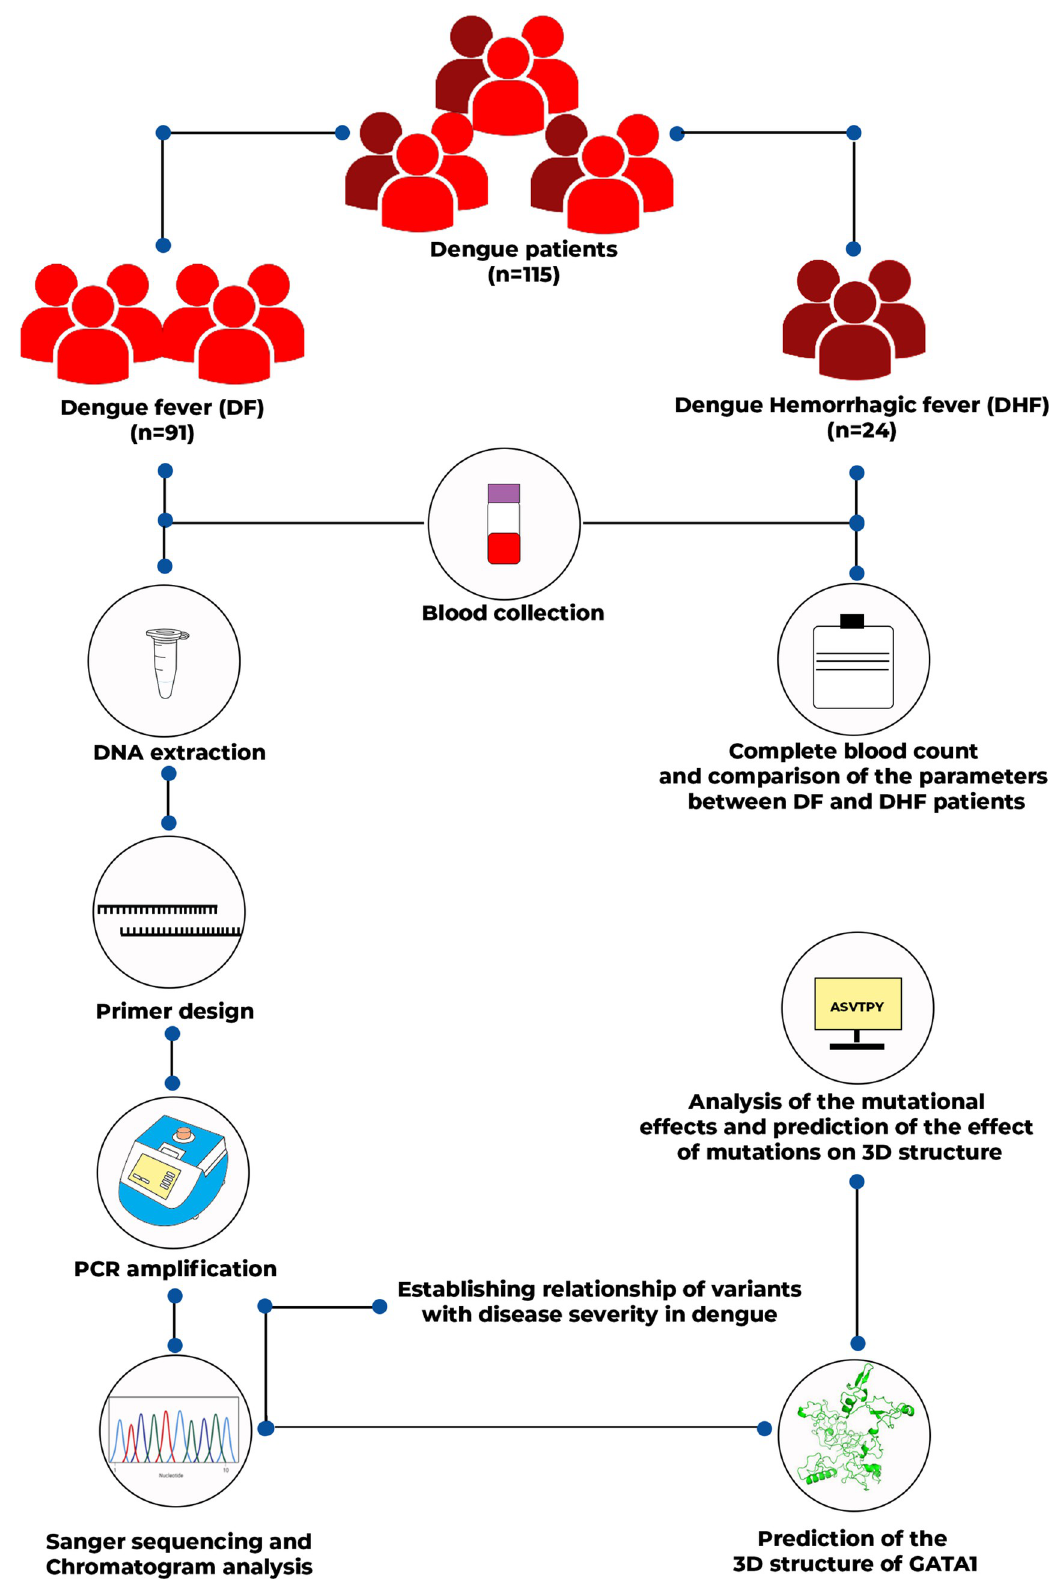
Fig 1. Graphical representation of the methodology undertaken during the study.